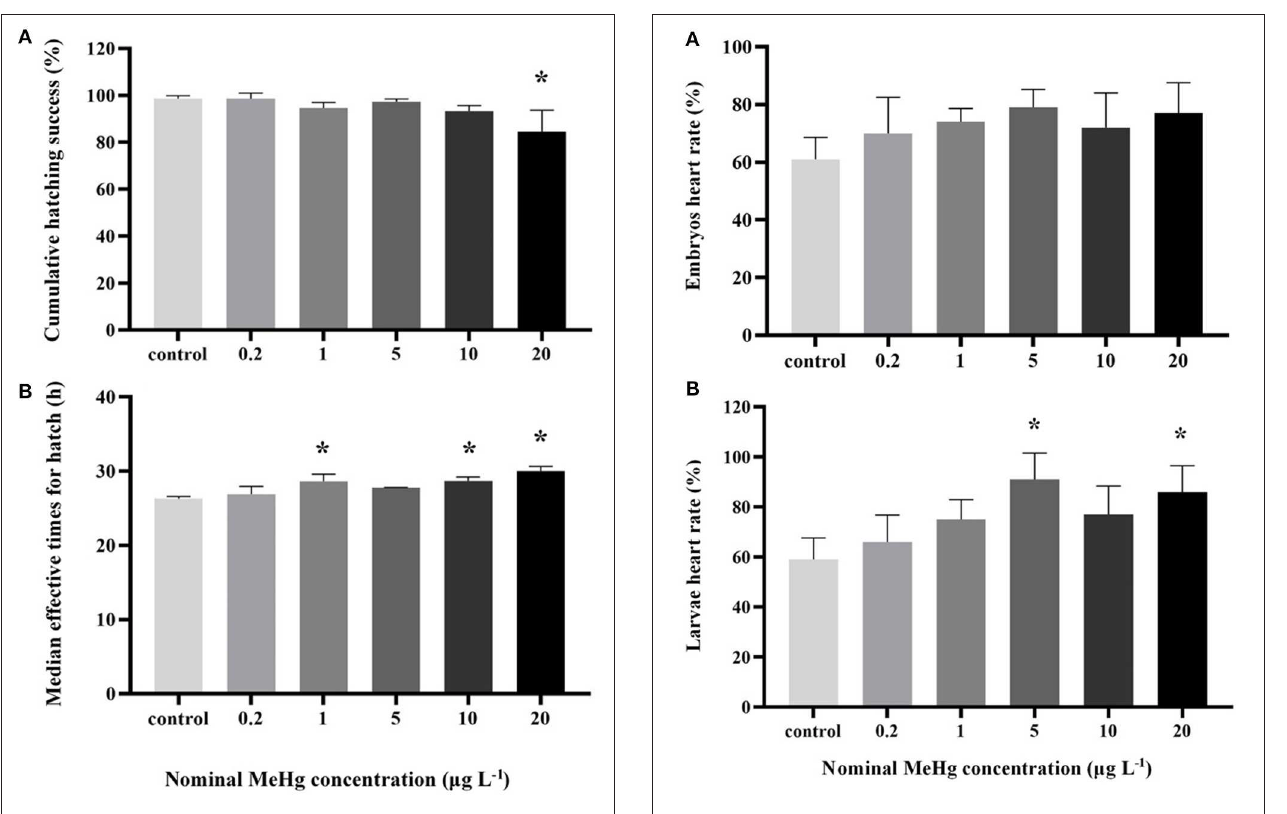
FIGURE 1 | (A) Cumulative hatching success and (B) METs of the large yellow croaker embryos by MeHg exposure (mean ± S.D.; n = 4; *indicated significant difference compared to the control group at p < 0.05).